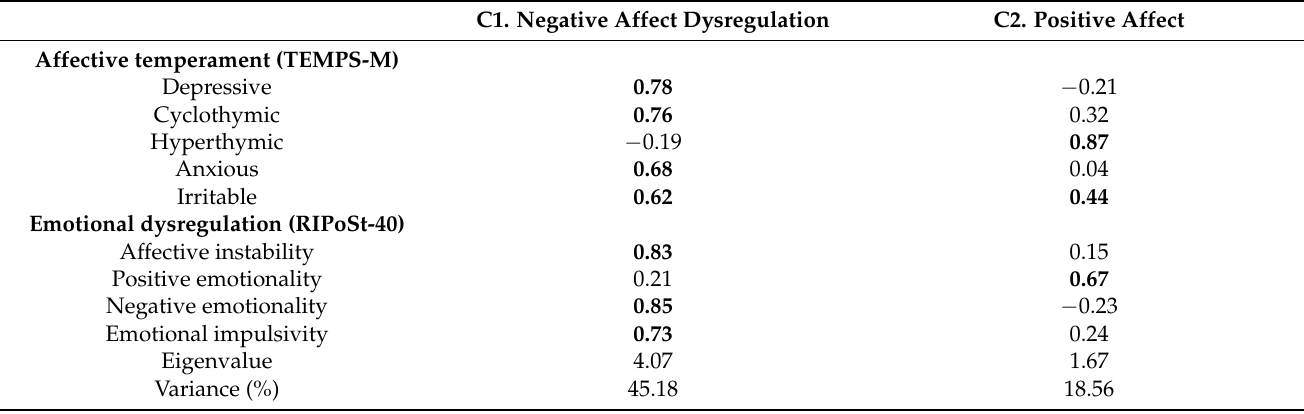
Table 3. Principal component analysis results (two-component solution). Component loadings of each item in each component are shown. Component loadings > 0.4 are shown in